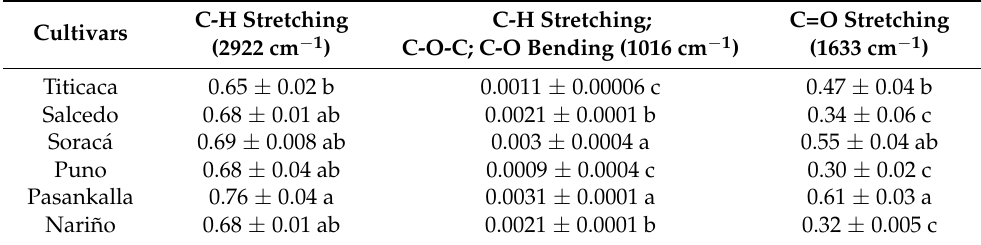
Table 2. Band intensities distinctive to lipids, proteins and starch.